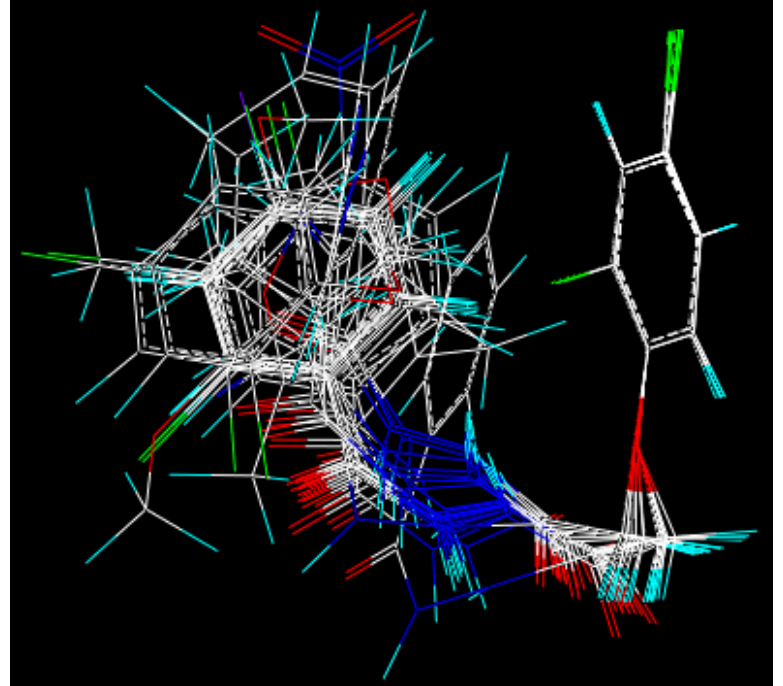
Figure 6. Superposition modes of